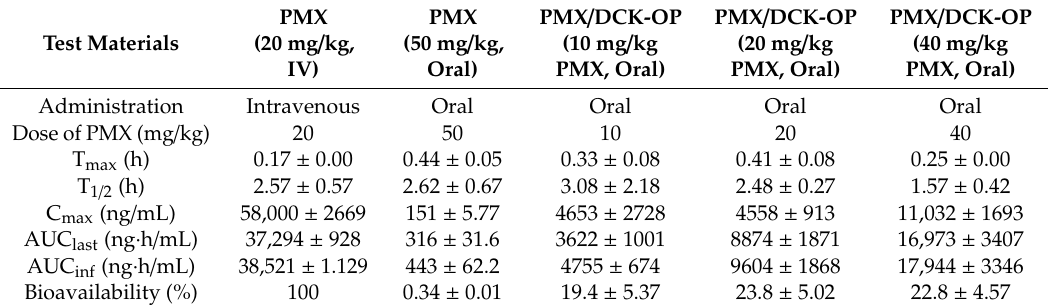
Figure 4. Venous plasma concentration-time profiles of PMX after single intravenous administration of PMX (20 mg / kg) and oral administration of PMX (50 mg / kg), PMX / DCK-OP (10 mg / kg PMX), PMX / DCK-OP (20 mg / kg PMX), or PMX / DCK-OP (40 mg / kg PMX) in mice. Each value represents the mean ± SEM ( n = 4 for each group). Table 2. Pharmacokinetic parameters of PMX in mice after intravenous injection of PMX or oral administration of PMX or PMX / DCK-OP with various dose of PMX.